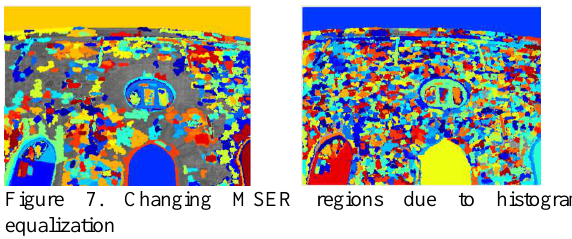
Figure 7. Changing MSER regions due to histogram